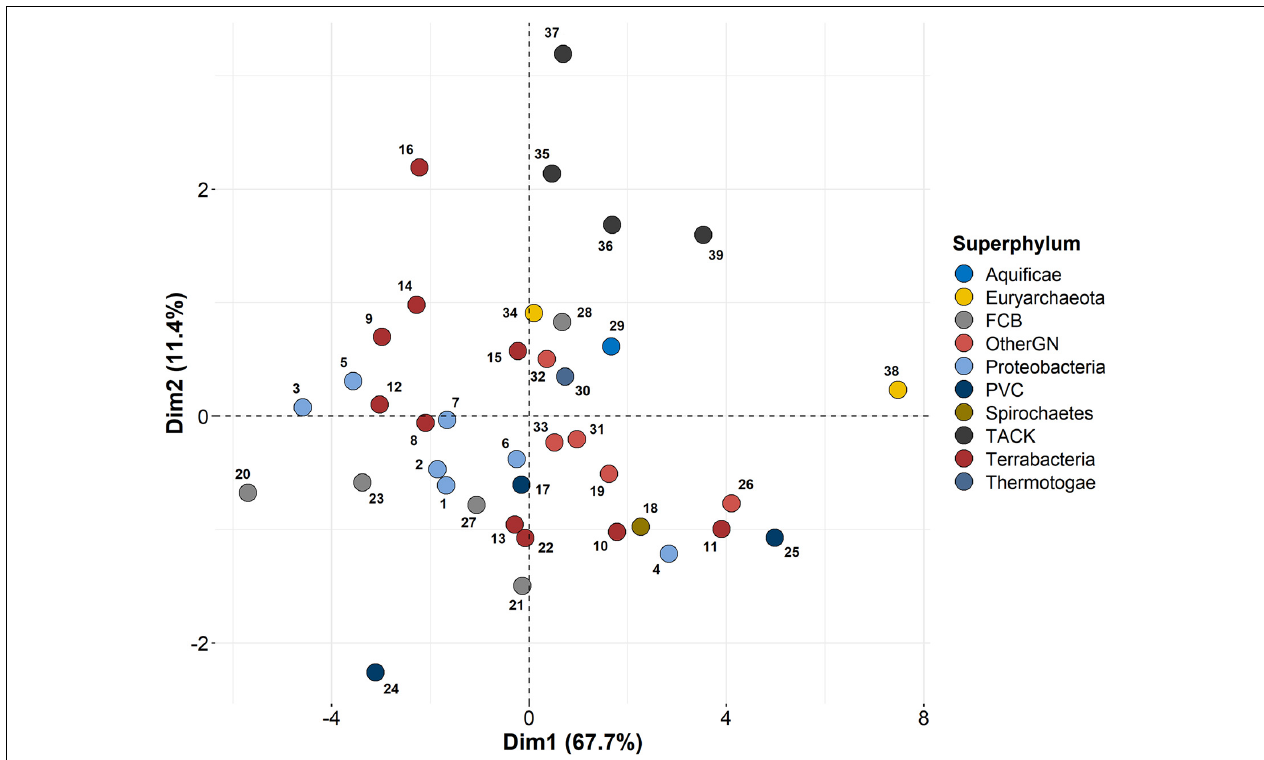
FIGURE 6 | Principal component analysis, considering the mean values for the following 11 variables: genome size, number of proteins, number of enzymes, and number of paralogous proteins, plus the average ratio of paralogous enzymes for each of the seven enzymatic classes. Each circle represents a single phylum, according to the KEGG Organisms Database, and those grouped into the same superphylum are depicted with the same color. The only exceptions that aren’t included into a supergroup but considered as individual phyla are the Aquificae, Thermotogae, and Spirochaetes. Single phyla are indicated by the